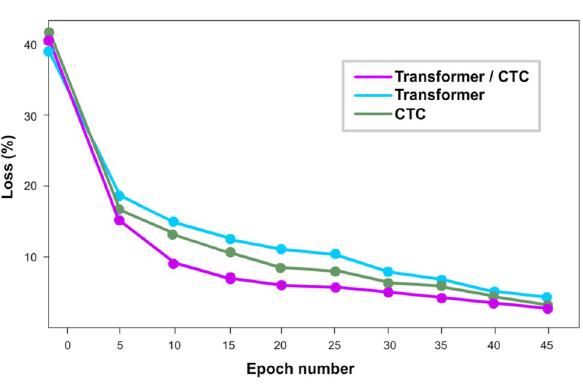
Figure 5. Comparative graph of Transformer + CTC and other models on the test set on Read